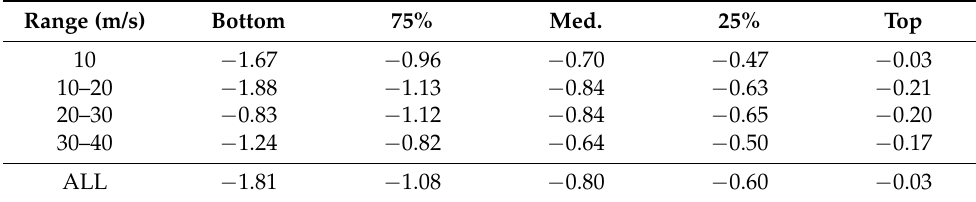
Table A4. The distribution of the required acceleration at the sailing start